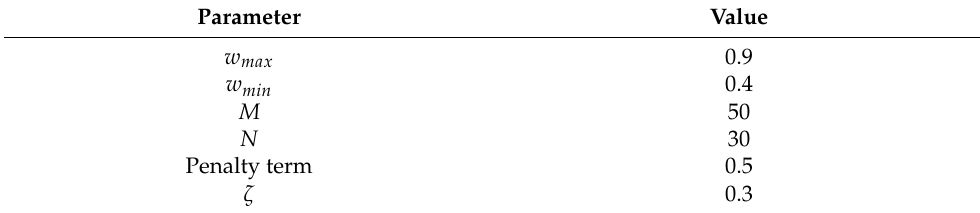
Table 5. Parameters of the PUPSO